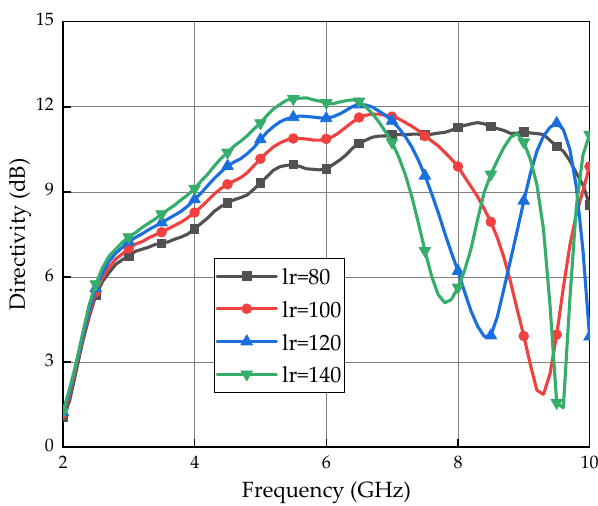
Figure 6. The endfire directivity of the sum beam for different lengths of corrugated groove sections.